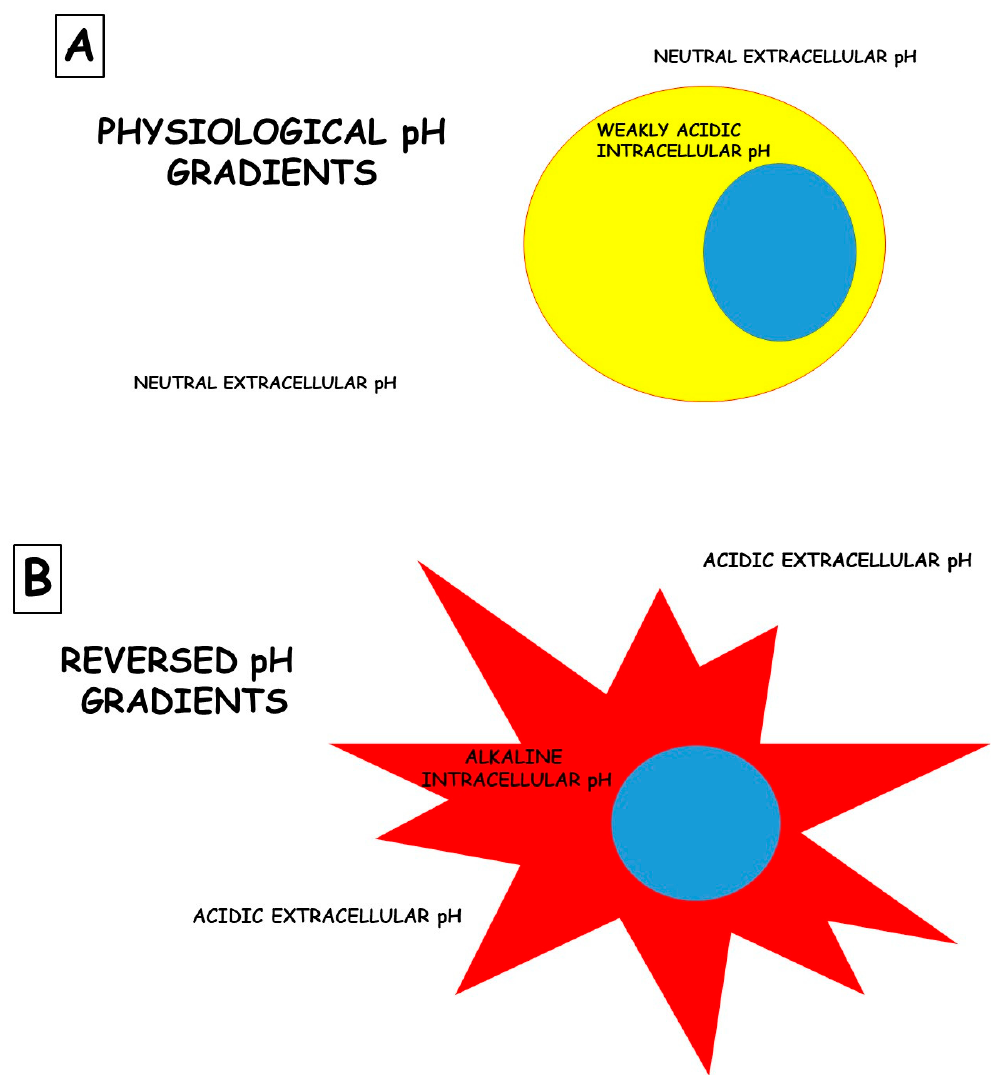
Figure 1. Differences in the pH gradients between normal ( A ) and tumor ( B ) cells. Notably, the presence of a deranged pH gradient in tumor cells does not allow chemical drugs to enter the cells and carry out their effects; instead, they are entirely protonated and, therefore, blocked outside the cells.